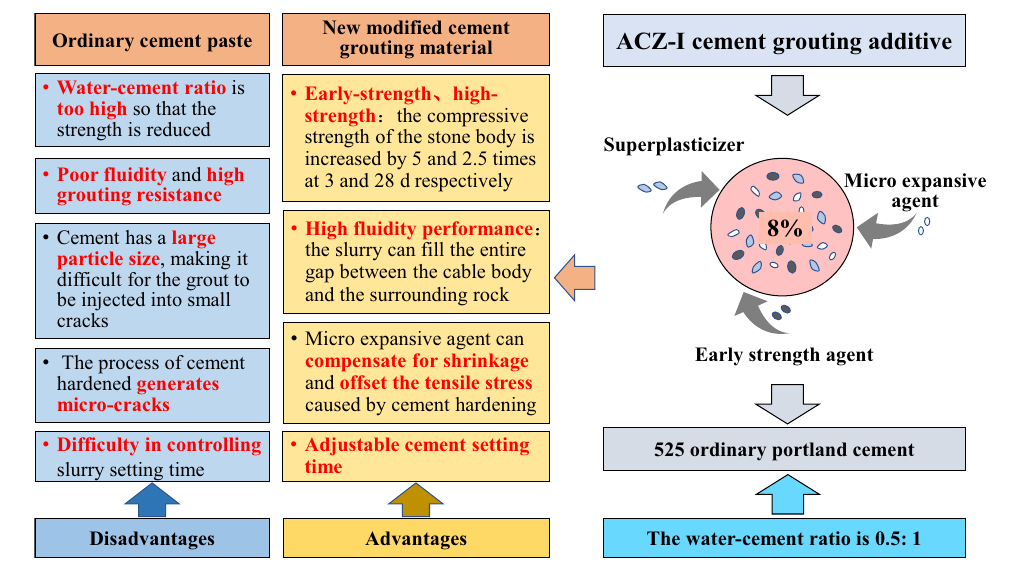
Fig. 22 Schematic of the advantages of modified grouting material